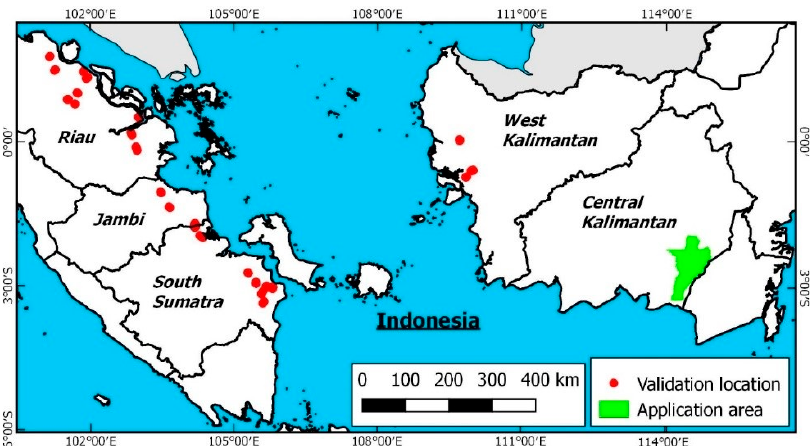
Figure 1. Map of eastern Sumatra and Kalimantan provinces showing canal water table depth (CWD) validation locations and application